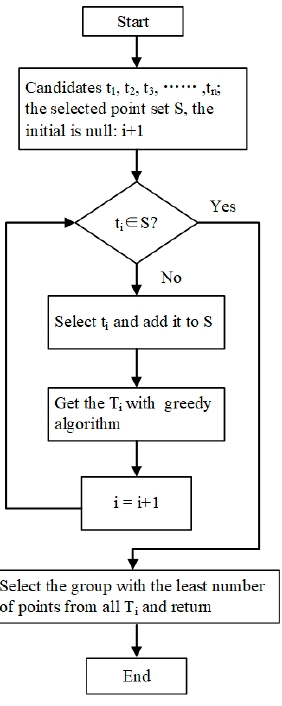
Figure 12. Flow chart of the tracking chassis trajectory